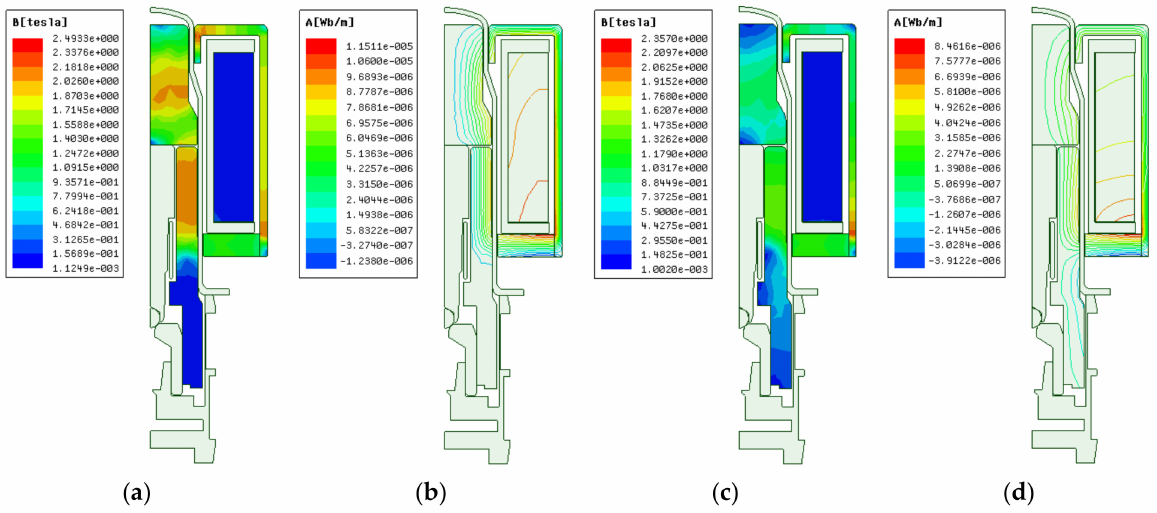
Figure 14. Permanent magnet TCV: ( a ) magnetic flux density at 3.4 A; ( b ) magnetic field strength at 3.4 A; ( c ) magnetic flux density at 0 A; ( d ) magnetic field strength at 0